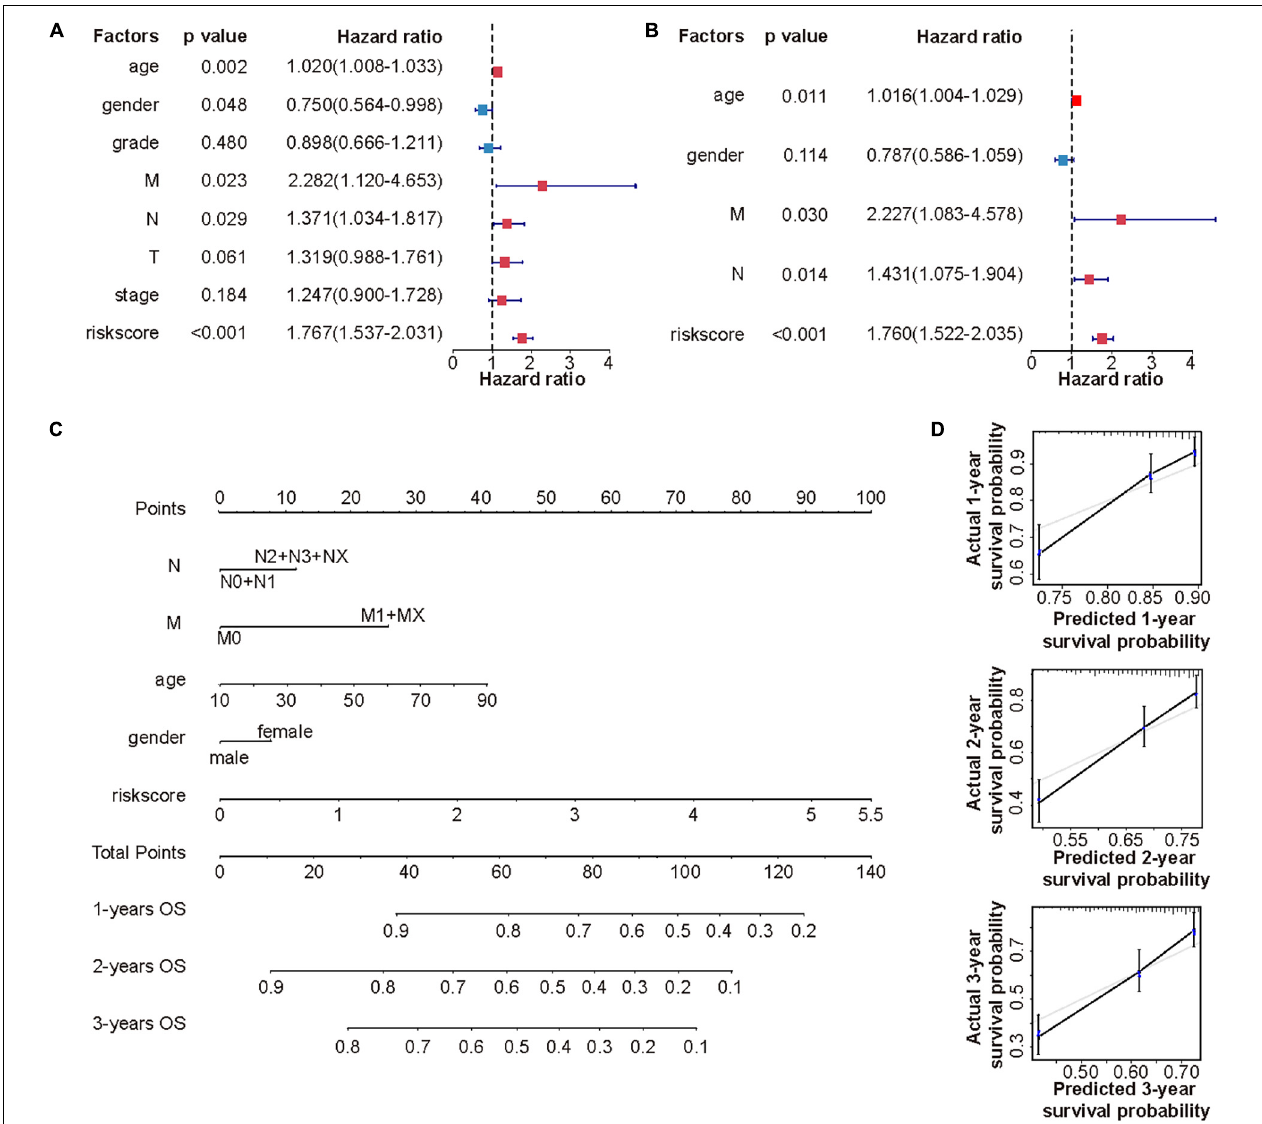
FIGURE 4 | Establishment of a novel nomogram based on CMS. Forest plots exhibited univariate (A) and multivariate (B) Cox regression analysis of clinical features and risk score in the TCGA cohort. (C) The nomogram for predicting 1-, 2-, and 3-year OS in TCGA cohort. (D) Calibration curves of nomogram on consistency between predicted and observed 1-, 2-, and 3-year survival in TCGA